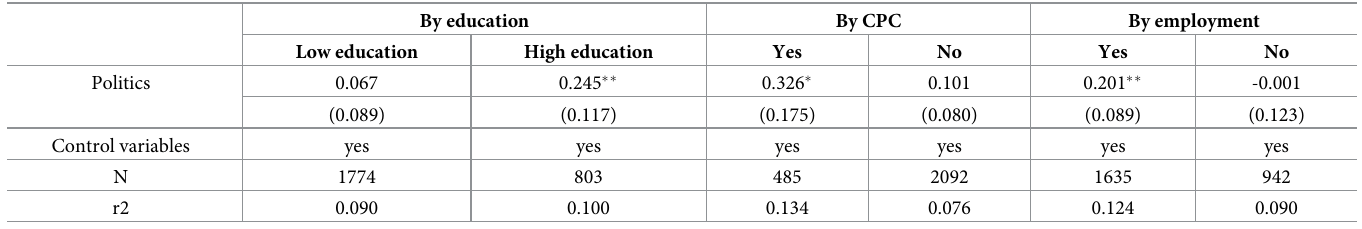
Table 6. Heterogeneity analysis.